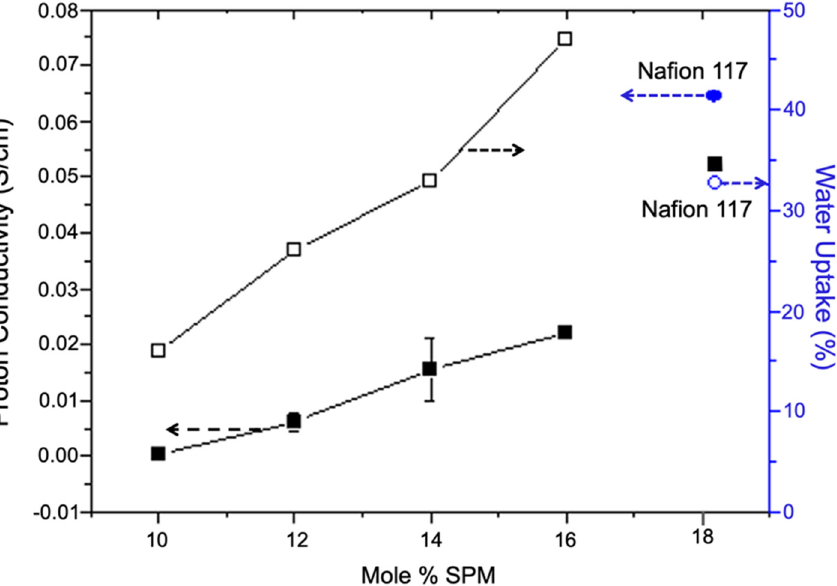
Figure 11. Influence of ionic SPM groups on the proton conductivities of the S20-Y membranes at room temperature, and the Nafion ® 117 membrane is included for comparison.